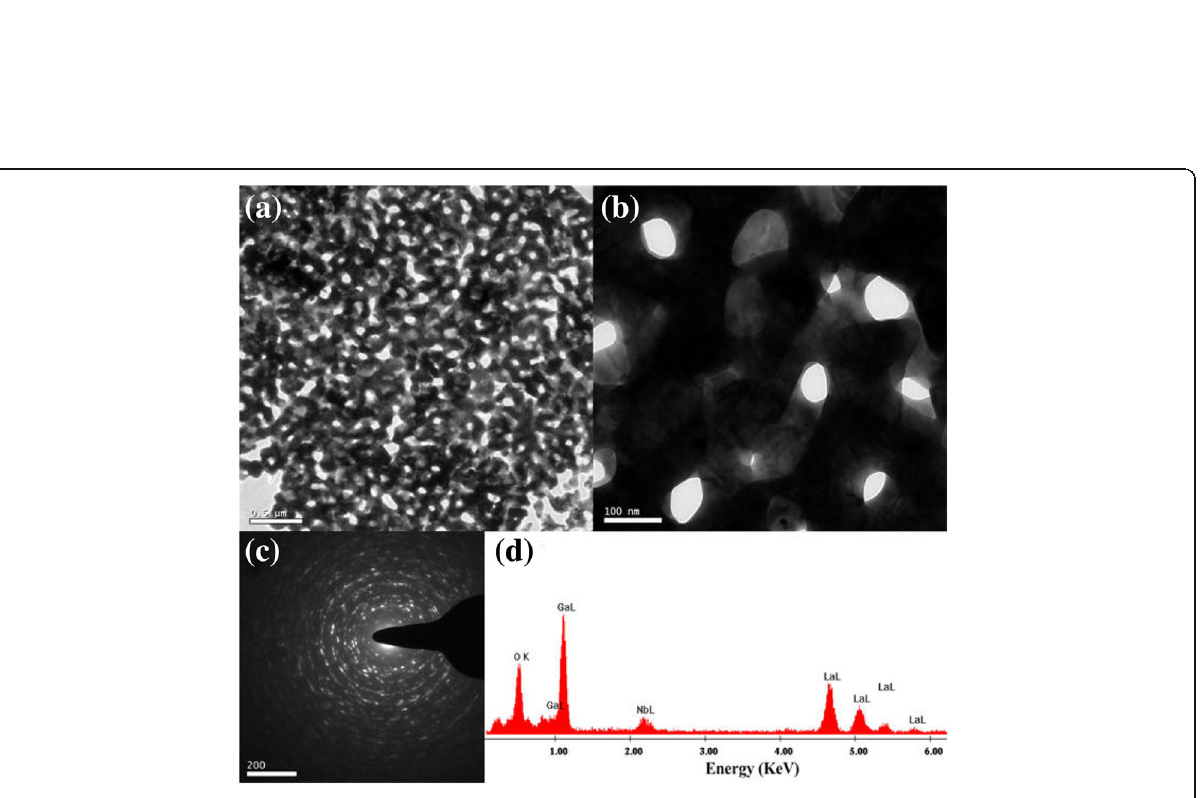
Fig. 5 a TEM images of as-synthesized macroporous at 800 °C, b high-resolution TEM image of the macroporous, c electron diffraction pattern, and d EDX analysis of La 3 Ga 5.5 Nb 0.5 O 14 macroporous